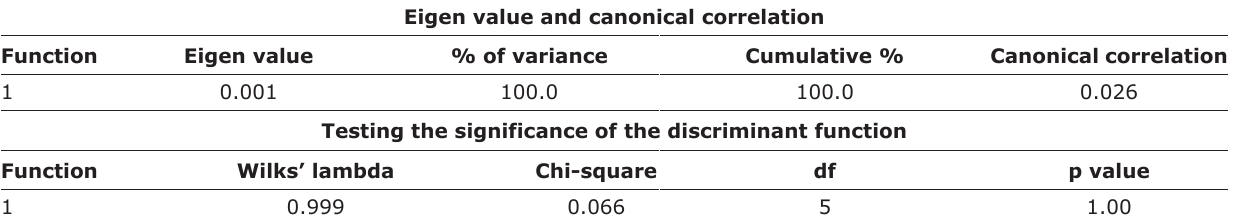
Table-6: Summary of the extracted canonical discriminant function (Eigen value, Wilks’ lambda, and canonical correlation) using all the performance traits.